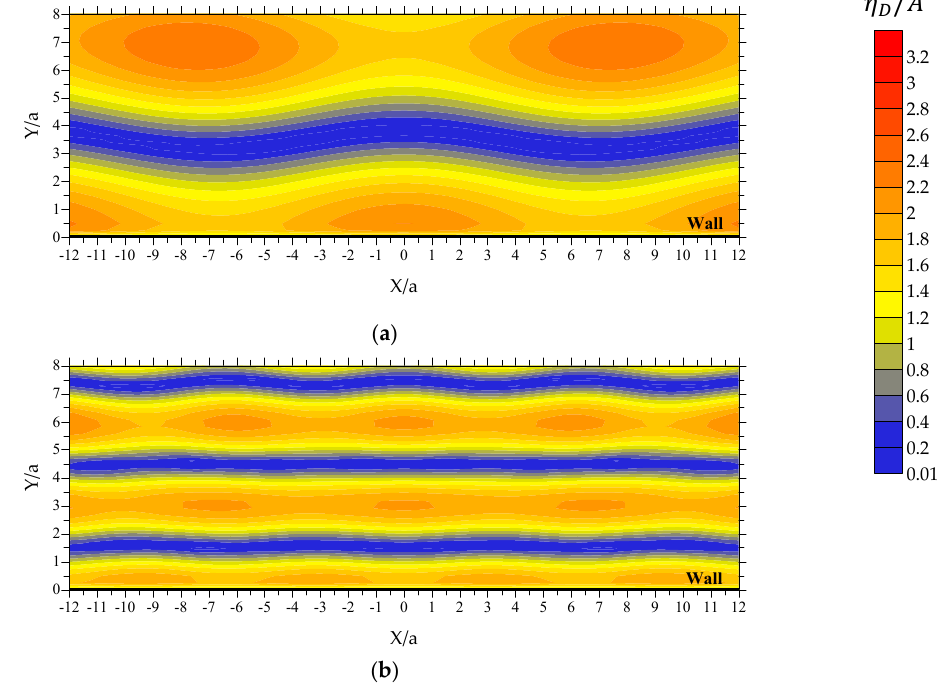
Figure 15. Spatial variation of η D / A at the seaward side of the wall with l w / a = 36 in the absence of WECs: ( a ) ω = 1.5 rad / s and ( b ) ω = 2.3 rad /